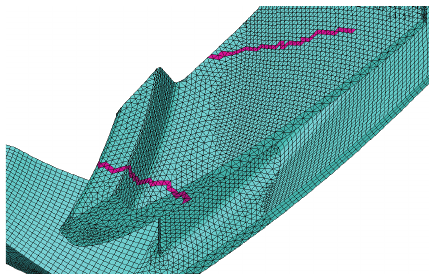
Figure 13: The crack that is completely through the eye of the impeller (𝑛𝑚 = 1500) .